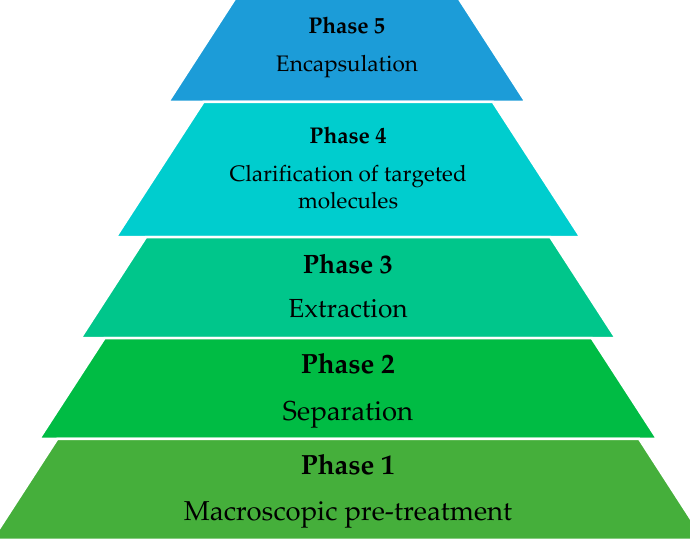
Figure 2. Stages of recovery of compounds of interest from agri-food SWL.